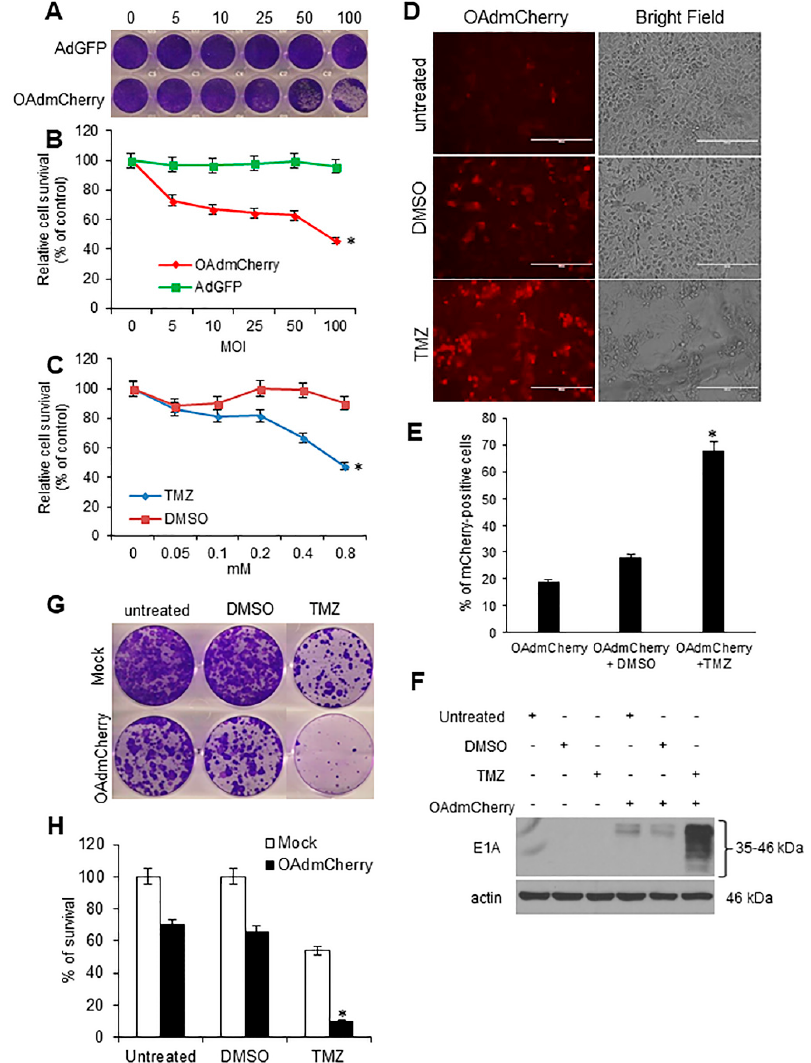
Figure 6. Combined therapy increases viral replication and strongly inhibits clonogenic survival in mouse triple-negative breast cancer (TNBC) cells: ( A ) 4T1 cells were infected with oncolytic adenovirus mCherry (OAdmCherry) or adenovirus expressing green fluorescent protein (AdGFP) at different multiplicity of infection (MOI) concentrations for 72 h. Crystal violet staining was used to evaluate cytopathic effect (CPE). A representative staining of three independent experiments is shown. ( B ) Relative cell survival was calculated by measuring the absorbance of solubilized dye at 590 nm. ( C ) 4T1 cells were treated with TMZ at different concentrations for 72 h. Cell survival was calculated by MTT assay. Results represent the mean of three repeated measurements ± standard deviation (SD; error bars) (* p < 0.05). ( D ) 4T1 cells were infected with OAdmCherry at a MOI concentration of 10 alone or in combination with TMZ or vehicle dimethyl sulfoxide (DMSO). Expression of mCherry was evaluated by fluorescence microscopy. Scale: 200 µm. ( E ) Percentage of mCherry-positive cells calculated relative to number of cells in the field. Results represent the mean of three repeated measurements ± standard deviation (SD; error bars) (* p < 0.05). ( F ) Expression of (Ad) E1A was evaluated 72 h post treatment by Western blot assay. Actin was used as a loading control. A representative assay is shown from three performed. ( G ) 4T1 cells were infected with OAdmCherry alone or in combination with TMZ or vehicle DMSO. Crystal violet staining was used to evaluate clonogenic survival. ( H ) Percentage of cell survival calculated relative to the untreated control. Results represent the mean of three repeated measurements ± standard deviation (SD; error bars) (* p <